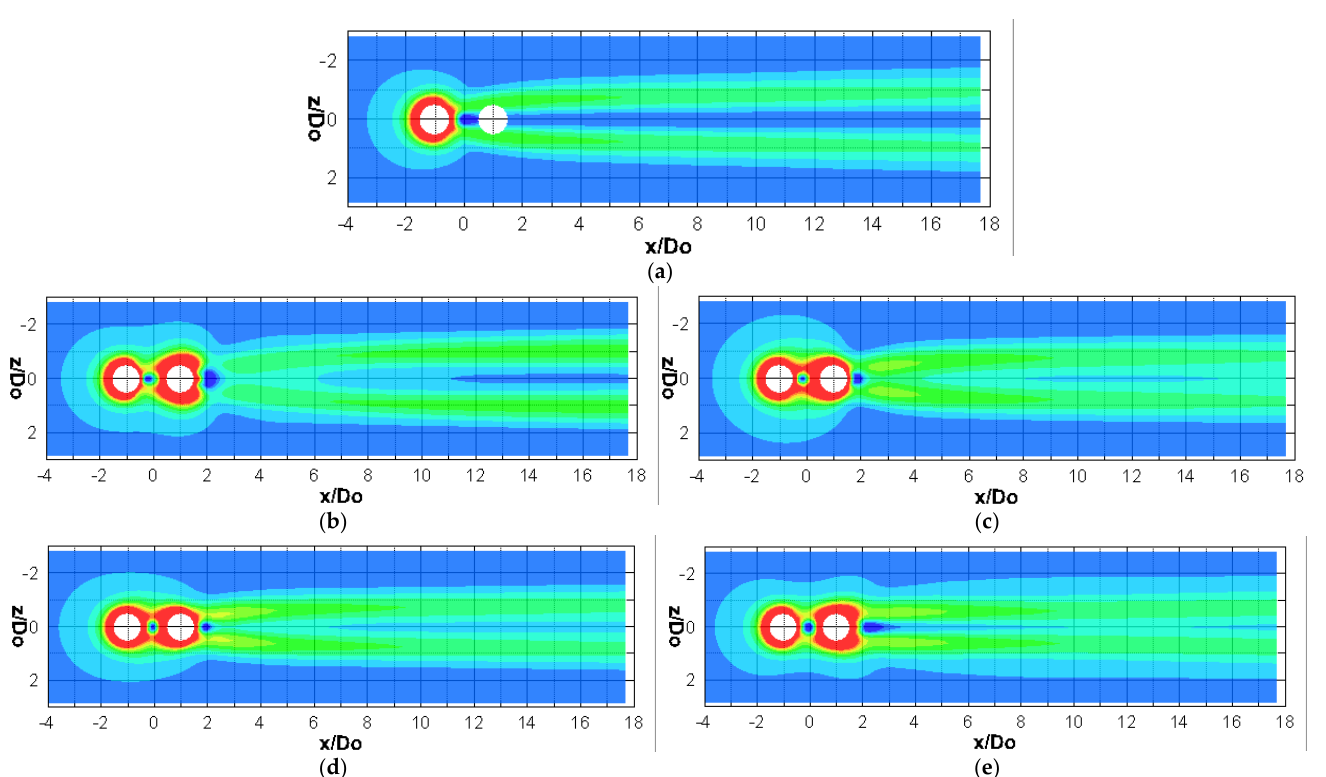
Figure 16. Time-averaged excess wall shear stress, ( a ) single SJ, ( b ) Δ ϕ = 0, ( c ) Δ ϕ = π / 2, ( d ) Δ ϕ = π , ( e ) Δ ϕ = 3 π / 2.The color map can be referred to Figure 11.